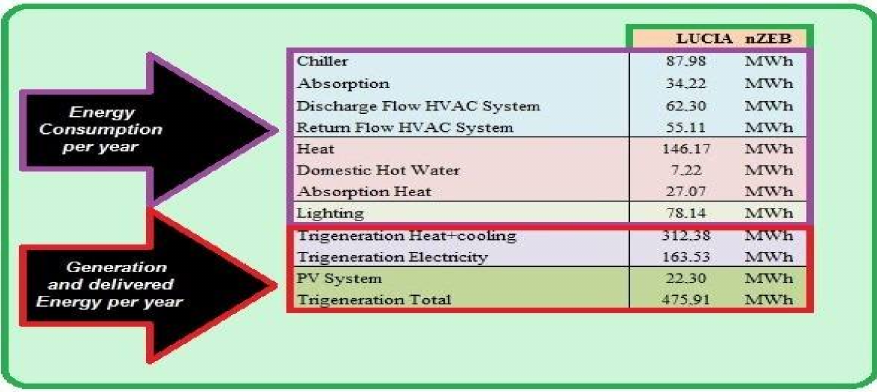
Figure 10. Energy Consumption in MWh of the nZEB LUCIA per year.